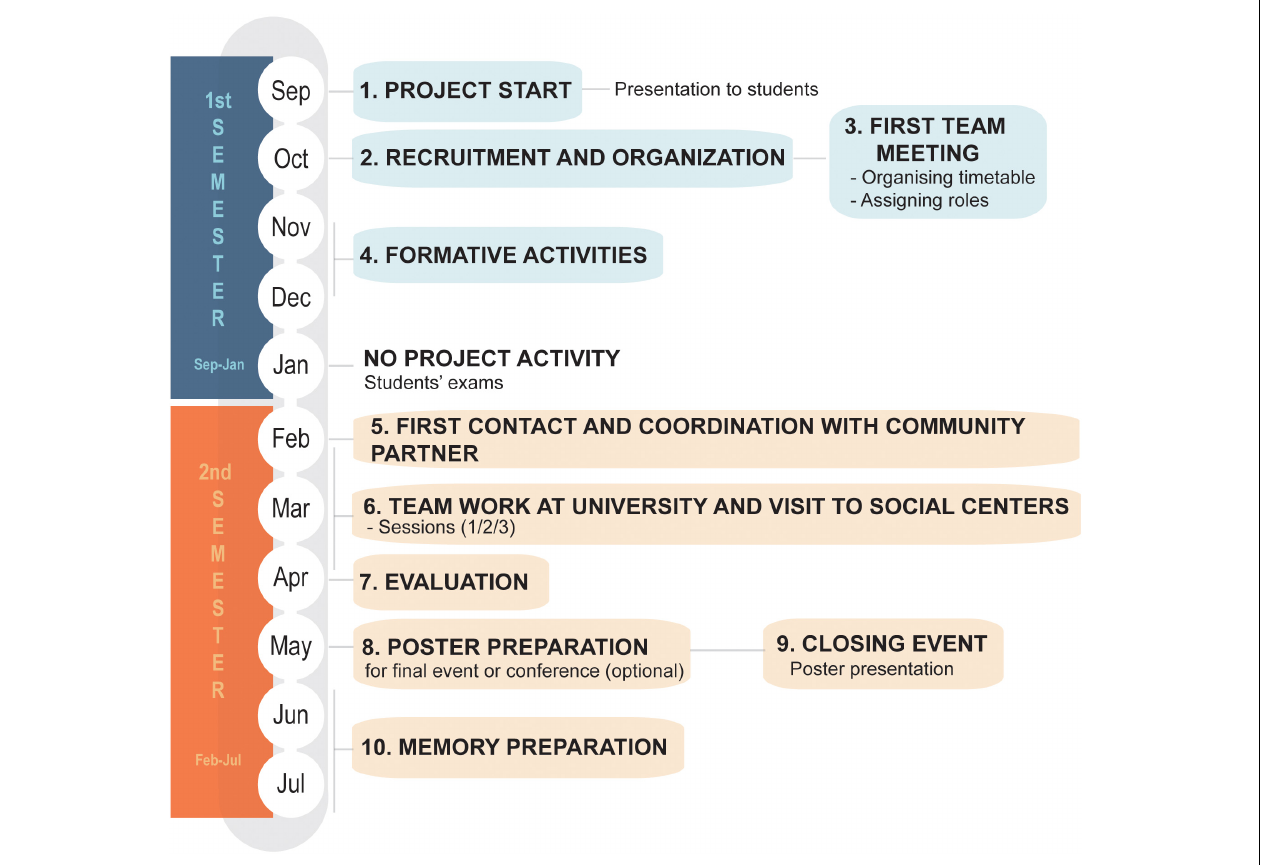
FIGURE 1 | Timeline of Movies and Infectious Diseases Serving-Learning (S-L) project at Universidad Complutense de Madrid, Spain, along a single academic